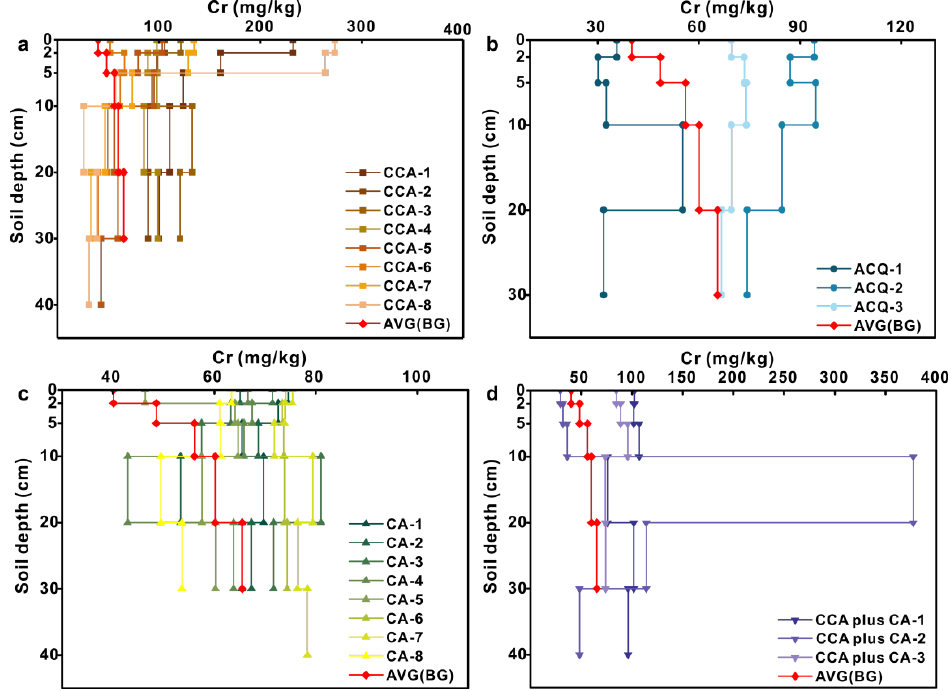
Figure 4. Vertical distribution of Cr concentration in soil samples under wooden walkway with four treatments: ( a ) CCA treatment; ( b ) ACQ treatment; ( c ) CA treatment; ( d ) CCA plus CA treatment.